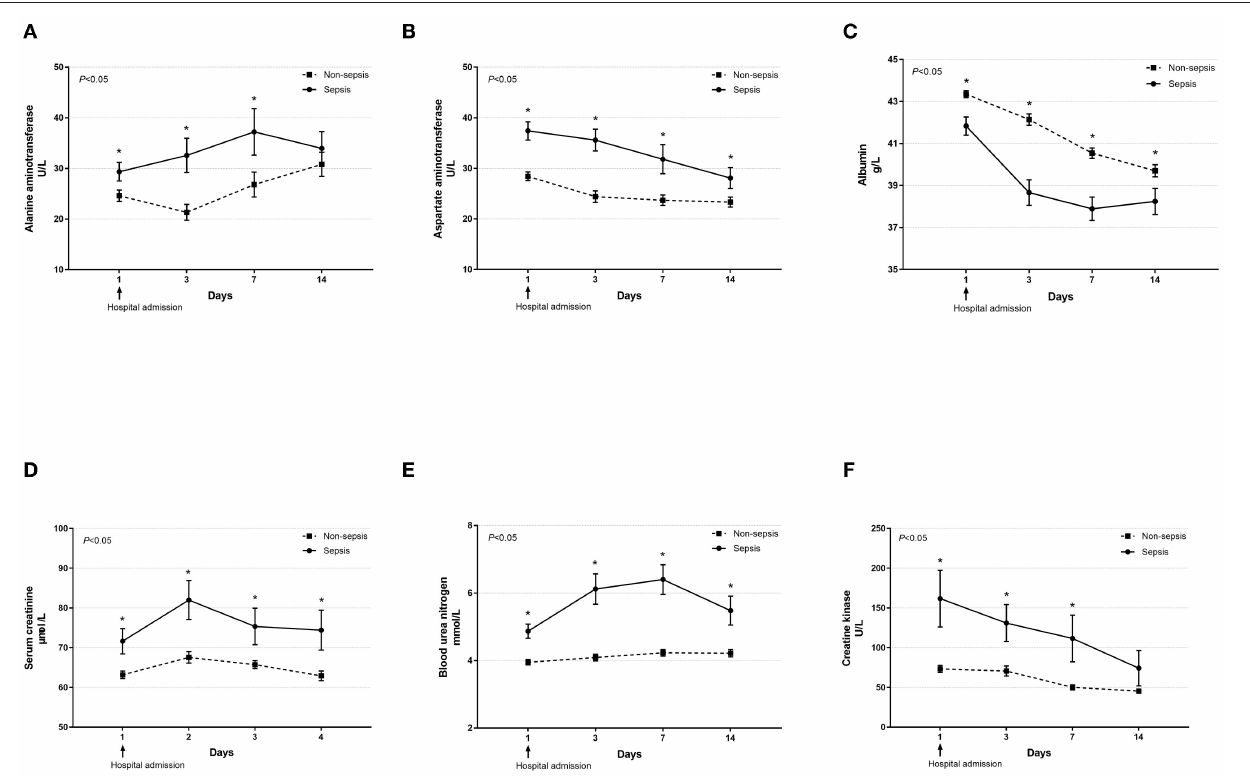
FIGURE 3 | Dynamic profiles of indicators for organ function in septic and non-septic COVID-19 patients. The levels of alanine aminotransferase (A) , aspartate aminotransferase (B) , albumin (C) , serum creatinine (D) , blood urea nitrogen (E) , and creatinine kinase (F) in the peripheral blood obtained from septic and non-septic COVID-19 patients were monitored and compared on days 1, 3, 7, and 14 after hospital admission. Data were presented as mean ± SEM. * P < 0.05, septic patients vs. non-septic patients. Results were tested for significance by using a general linear model with corrections for repeated measures.